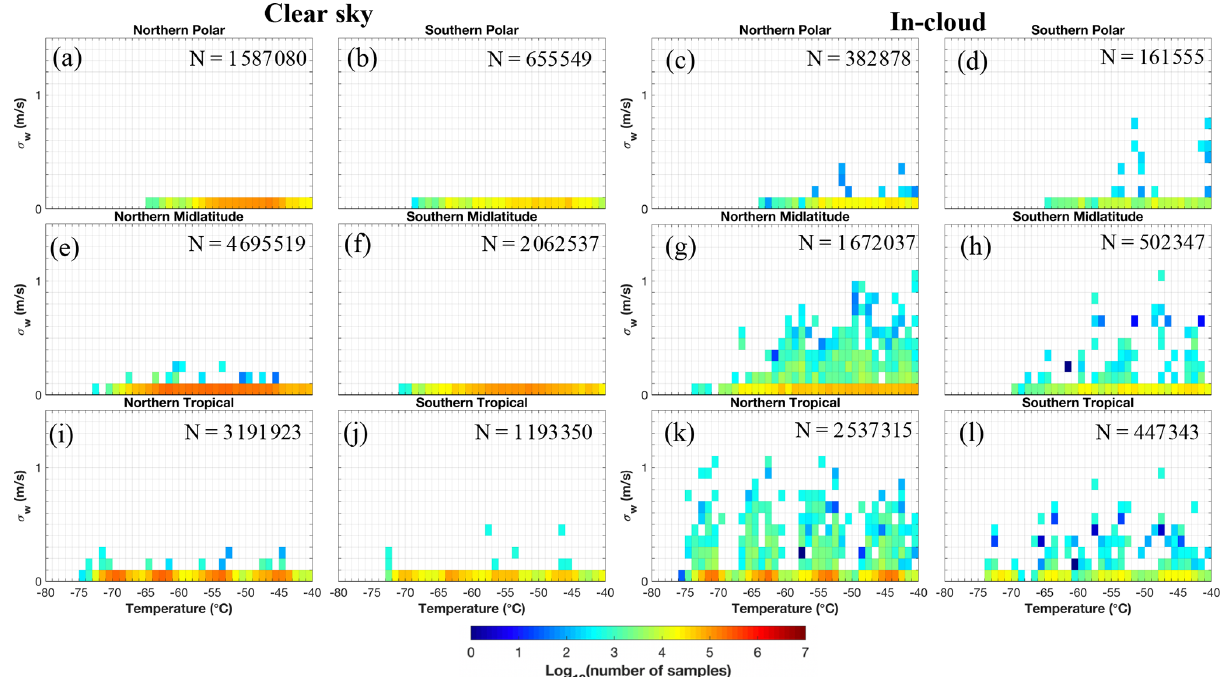
Figure 11. Similar to Fig. 9 but for the CAM6-nudg